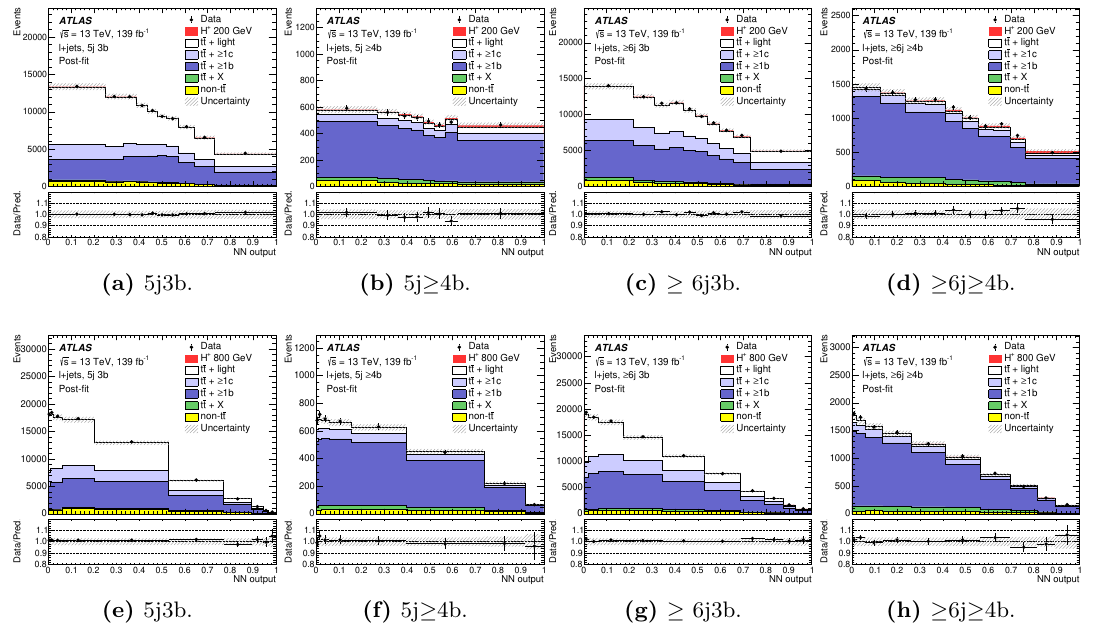
Figure 5 . Distributions of the NN output after the fit for the 200 GeV (top) and 800 GeV (bottom) H + mass hypotheses in the four analysis regions. The lower panels display the ratio of the data to the total prediction. The hatched bands show the uncertainties after the